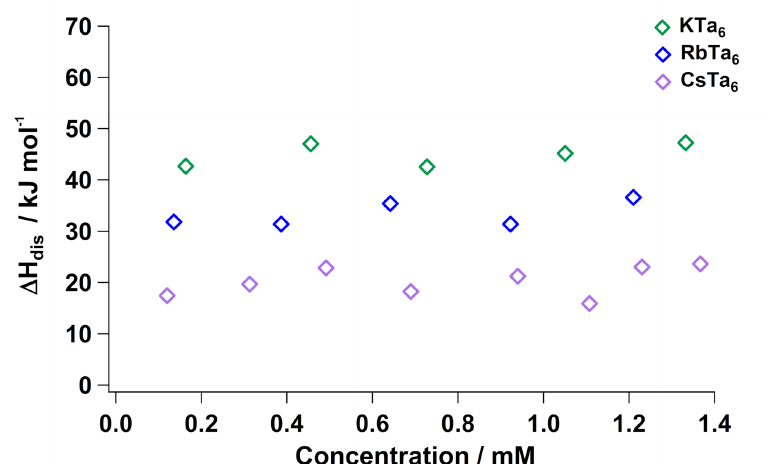
Figure 3. Enthalpy of aqueous dissolution ( ∆ H dis ) of Li–Ta hydroxide (1 M) solutions, normalized for lattice water. The hydrated enthalpies are provided in Tables S10–S13.